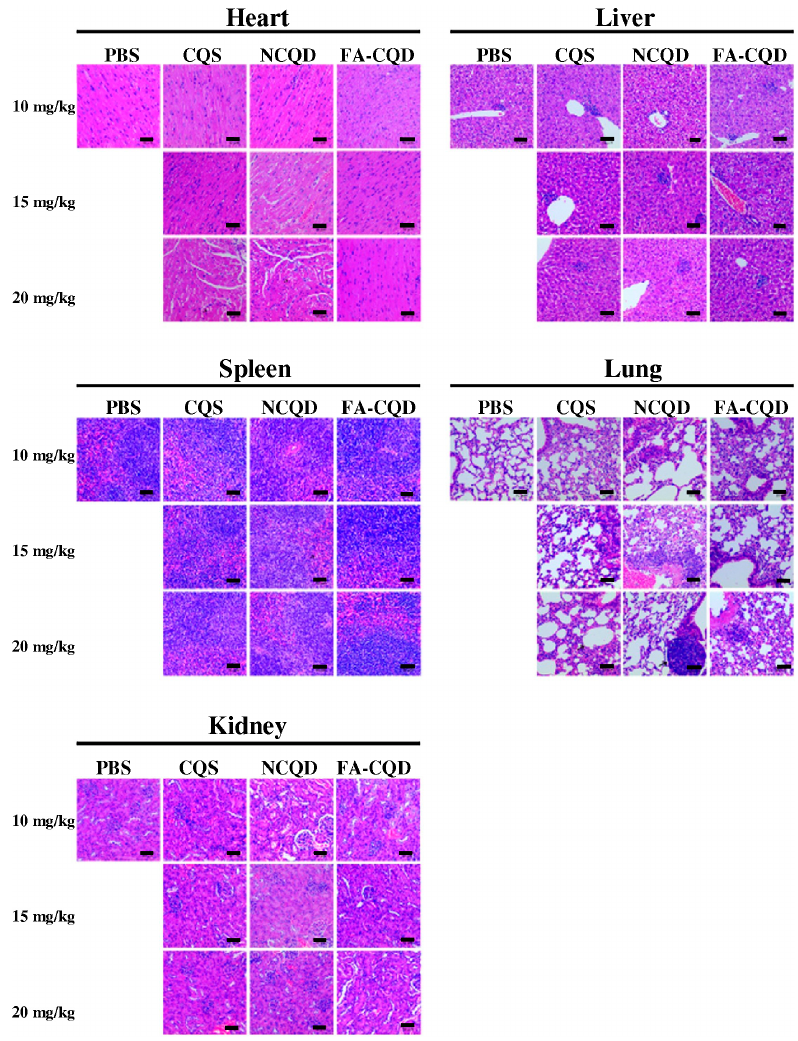
Figure 13. Histological analysis of the CQD materials to evaluate toxicity. Histological study of the heart, liver, spleen, lung, and kidney of mice at 14 days after intravenous injection of the CQD materials at different concentrations (scale bar = 50 mm). Reprinted from Chinese Chemical Letters , 31, by Shu Zhang, Xibo Pei, Yiyuan Xue, Jingyuan Xiong, Jian Wang, Bio-safety assessment of carbon quantum dots, N-doped and folic acid modified carbon quantum dots: A systemic comparison , 1654, copyright 2020, with permission from Elsevier [296] .